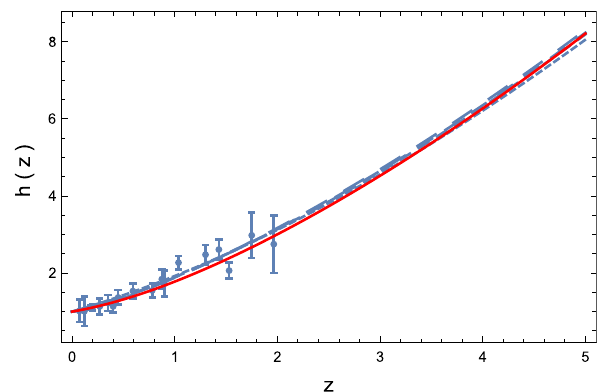
Fig. 4 Variation in the normalized function h as a function of the red- shift z in the Barthel–Kropina-FLRW dark energy model for differ- ent values of the parameter w of the dark energy equation of state: w = 1 . 45 (short dashed curve), w = 1 . 85 (dashed curve), w = 2 . 05 (longdashedcurve), w = 2 . 55(ultra-longdashedcurve),and w = 3 . 05 (ultra-ultra-long dashed curve), respectively. The red solid line repre- sents the prediction of the (cid:2) CDM model. The observational data are represented together with their error bars. The initial conditions used to numerically integrate the system of cosmological evolution equations are f ( 0 ) = 0 . 33, u ( 0 ) = 0 . 51, and h ( 0 ) = 1, respectively